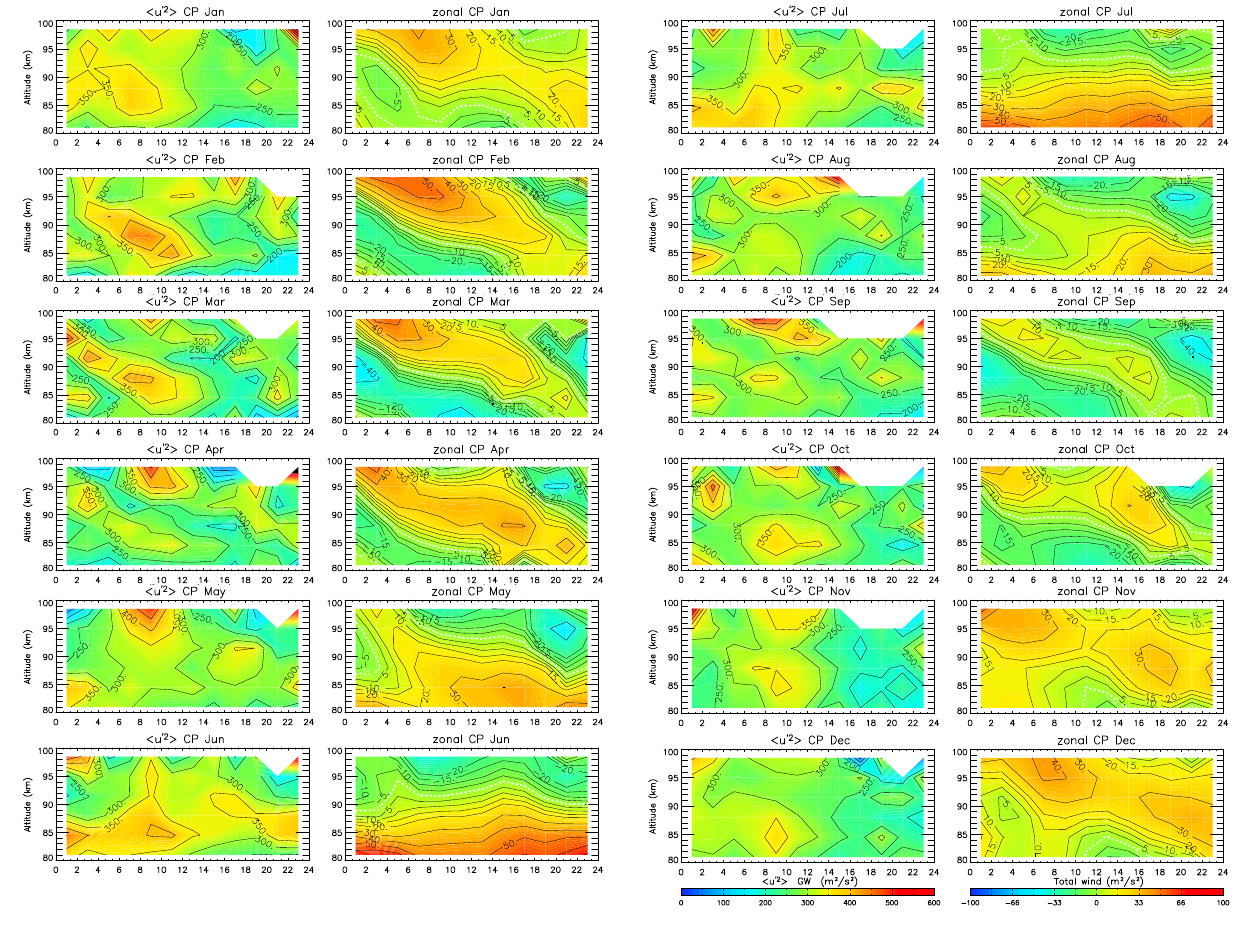
Fig. 7. The same as Fig. 5, but averaged from 1998 to 2008 over Cachoeira